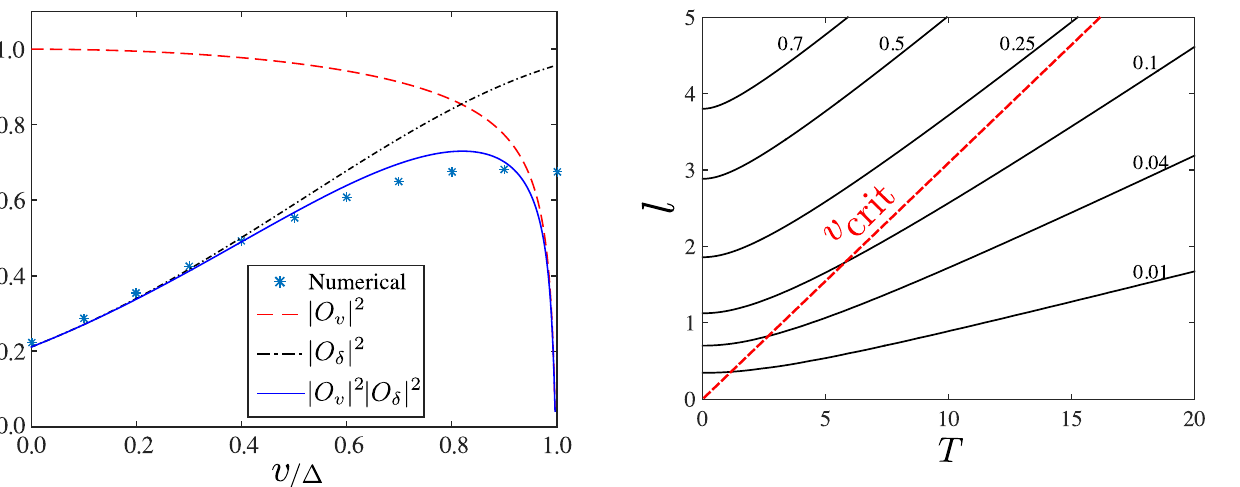
FIG. 4. The jump-move-jump protocol maximizes the product of the two functions O δ [Eq. (8)] and O v [Eq. (9)]. Here l = 4.32 and T = 12 [regime (I)] and we use s = 2.45 and β = 0.065. The ground-state projection analysis (solid blue) captures the key fea- tures of the ML-inspired (one-wall) JMJ strategy (blue stars) for low velocities v but tends to overestimate the penalty for moving at velocities near v crit .